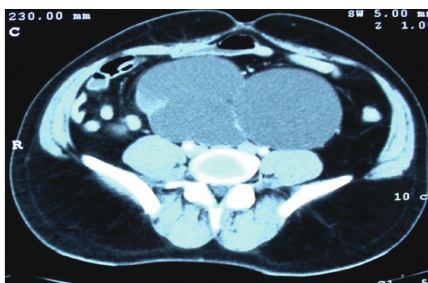
Figure 1: Axial CECT abdomen image showing grossly dilated right renal pelvic kidney with thinned out parenchyma.